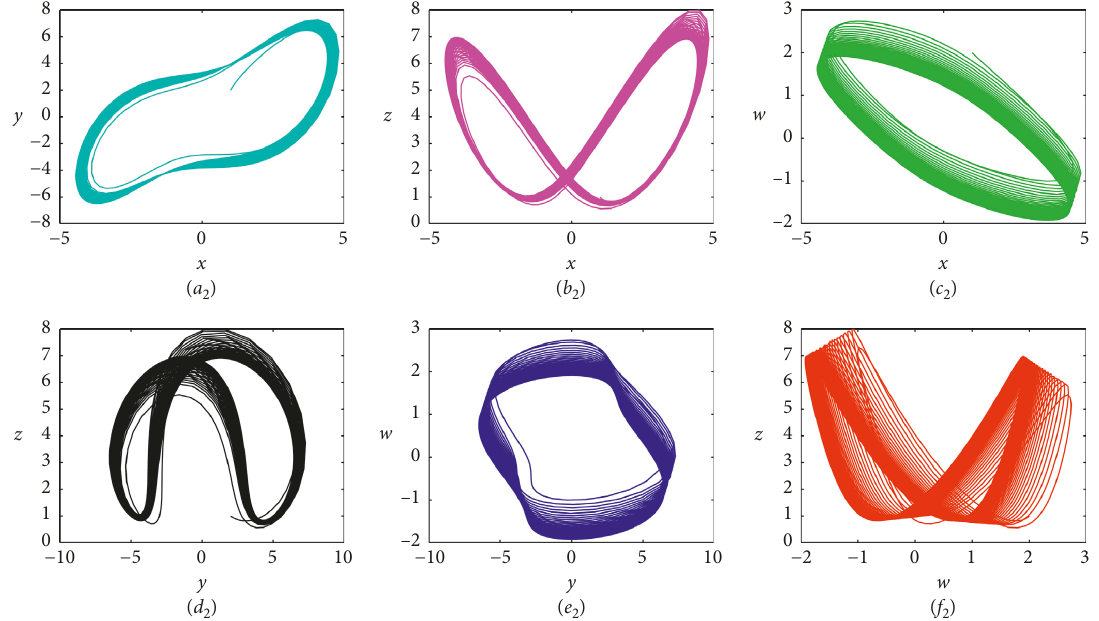
Figure 15: Phase portraits of Experiment 3 with a � 3 ,t � 3000: ( a ) on y − w plane; ( f plane; ( e 2